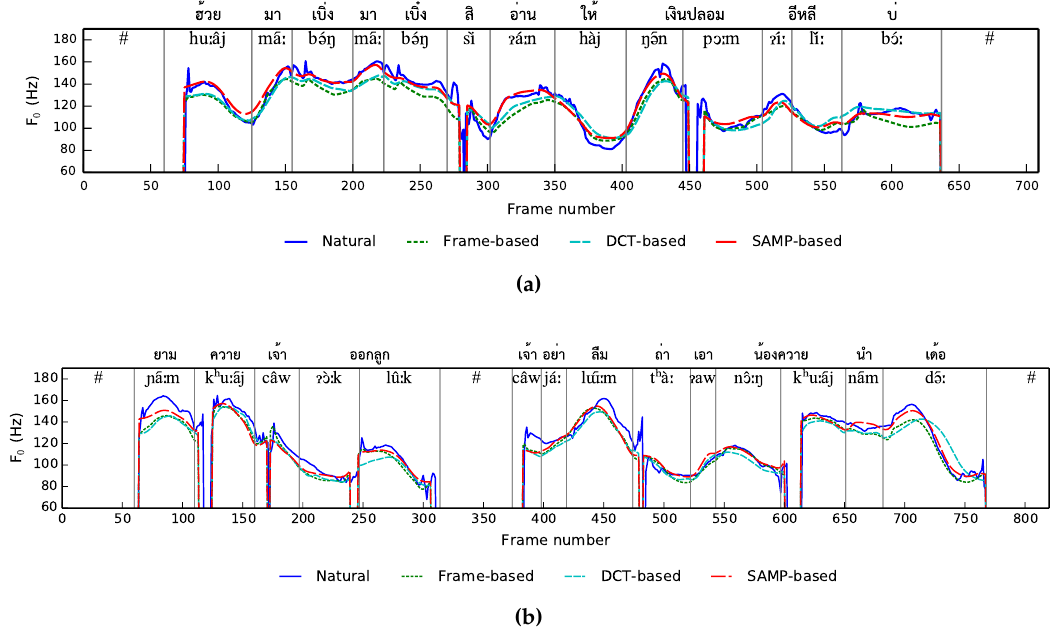
Figure 7. Comparison of F 0 contours generated using frame-based, DCT-based, and SAMP-based models, ( a ) the sentence means “Hey, come to see, I am checking for counterfeit money.” in English, ( b ) the sentence means “When your buffalo gives birth. You don’t forget to get its placenta.” in